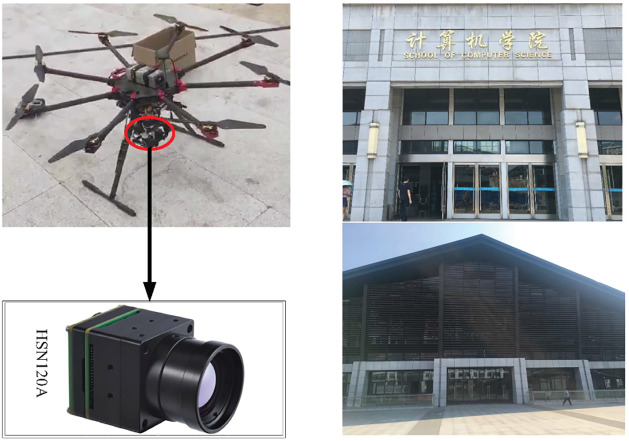
Experimental scene: An eight-rotor UAV equipped with HSN120A IR camera, with experiment conducted around Zhuoer Gymnasium in Wuhan University.